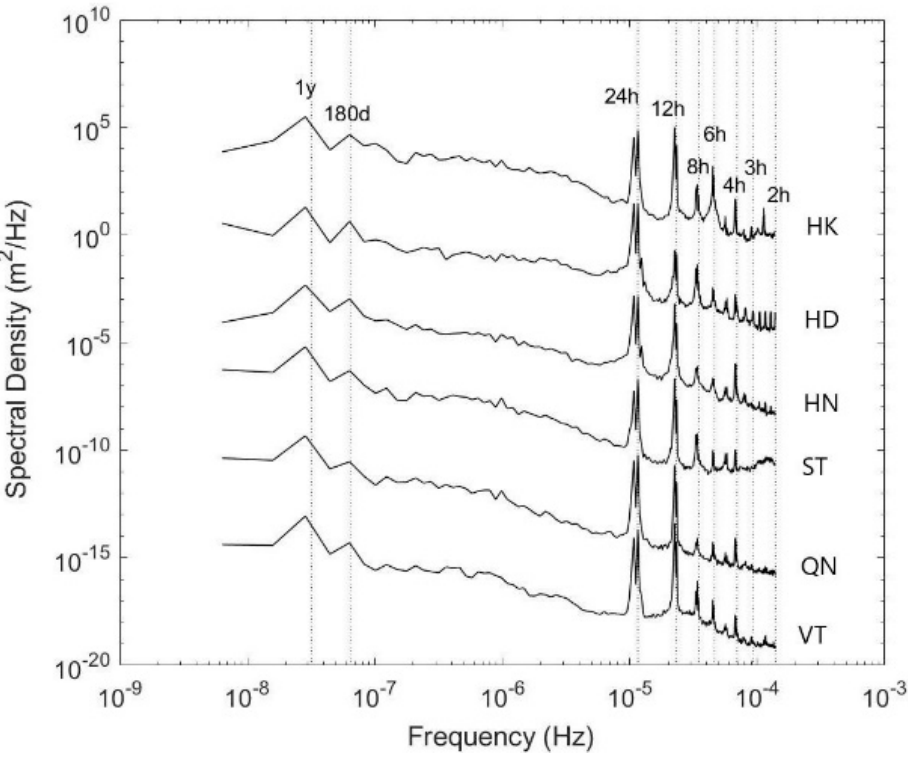
Figure 7. Spectral analysis of water levels at six stations from 2013 to 2017. Key: HK: Hong Kong; HD: Hon Dau; HN: Hon Ngu; ST: Son Tra, QN: Quy Nhon; VT: Vung Tau.